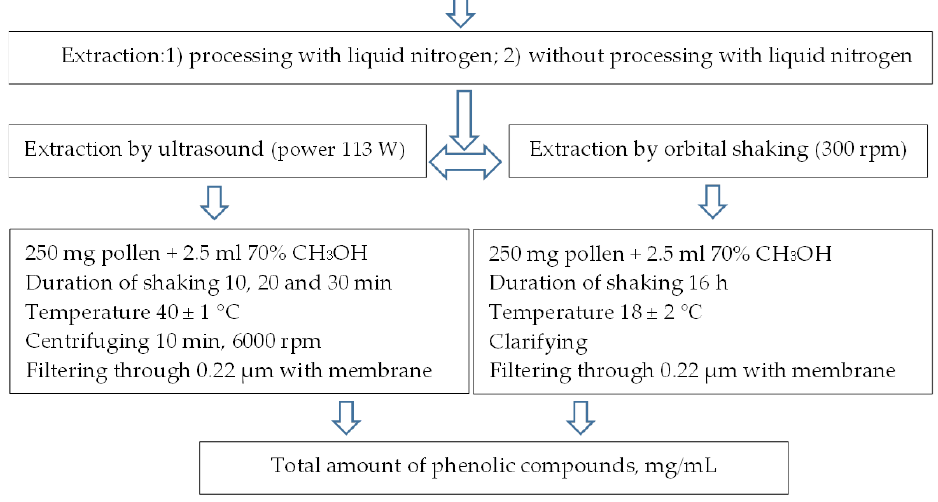
Figure 7. Scheme of methods applied for the extraction of free PC.